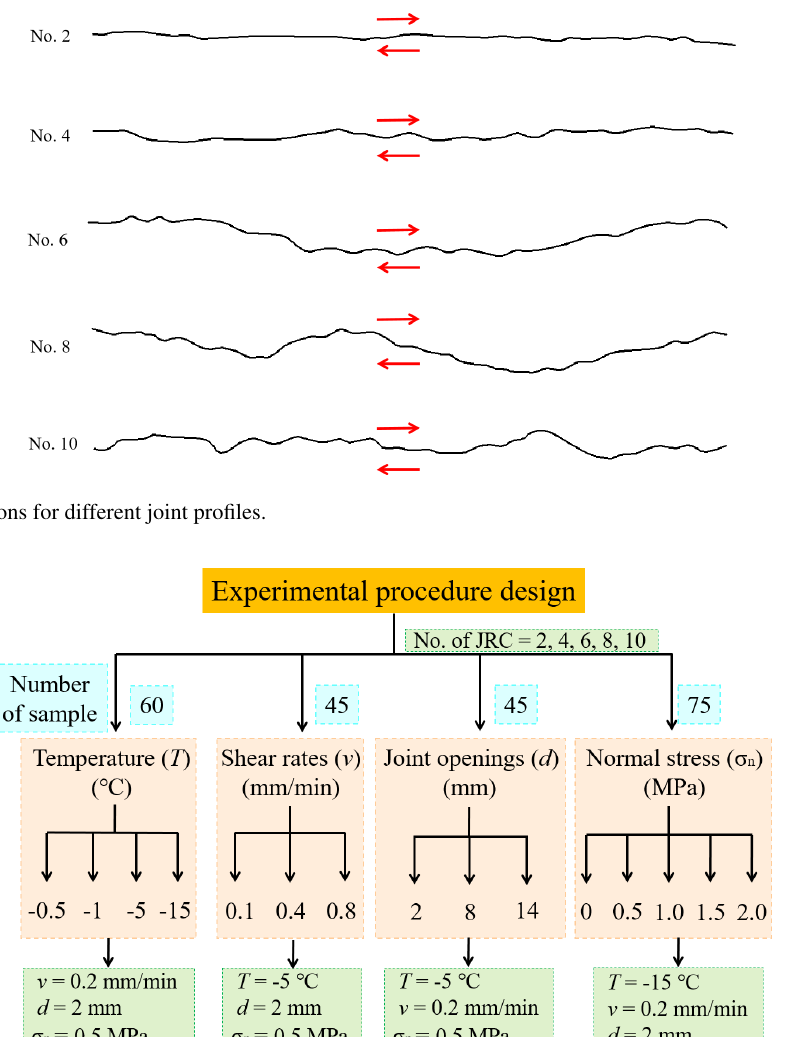
nal temperature change of ice-filled joint samples. In